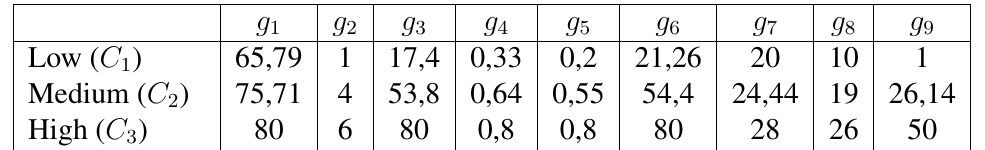
Table 2: Central profiles cp